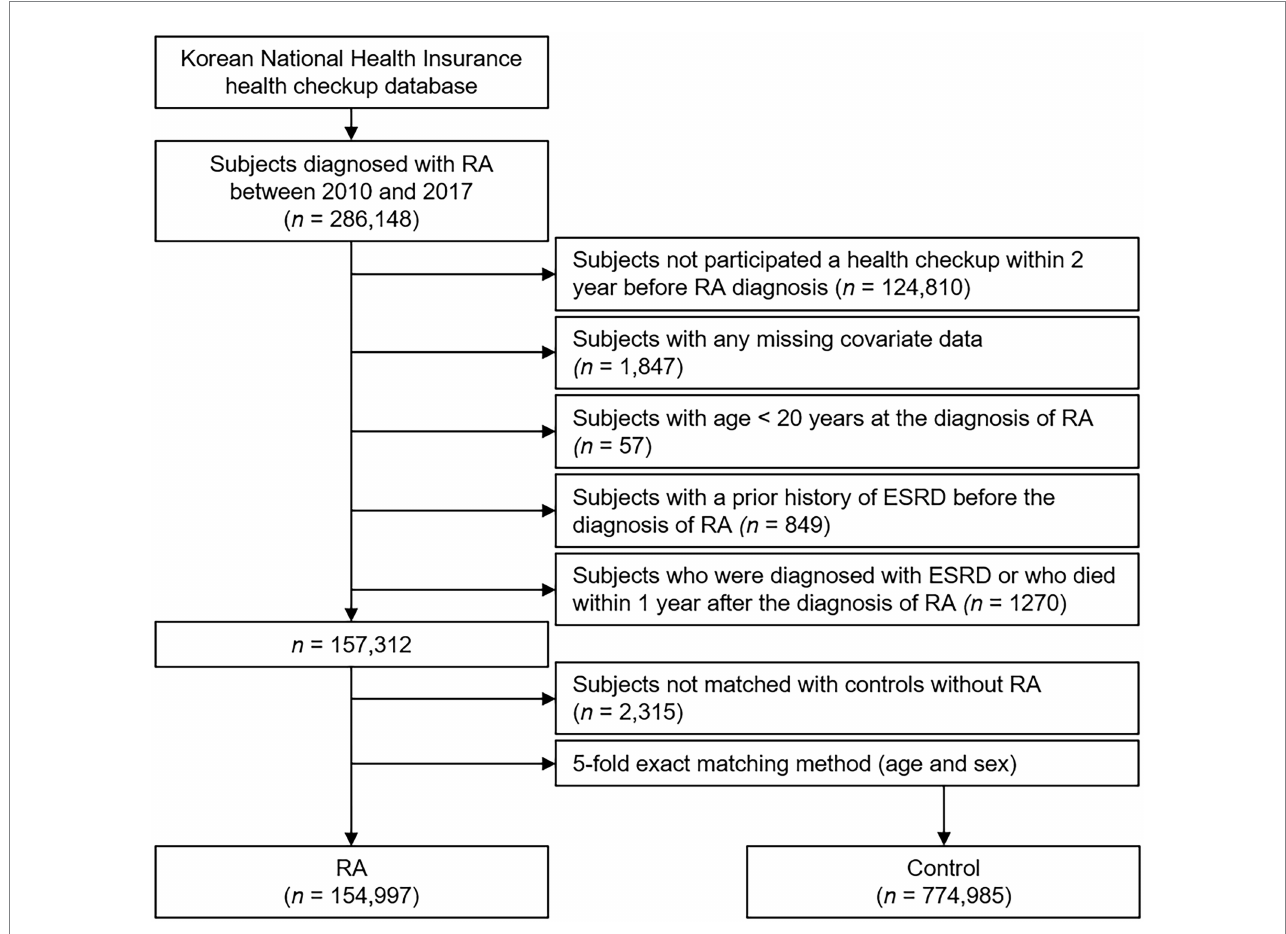
FIGURE 1 Flow diagram of the study population. ESRD, end-stage renal disease; RA, rheumatoid